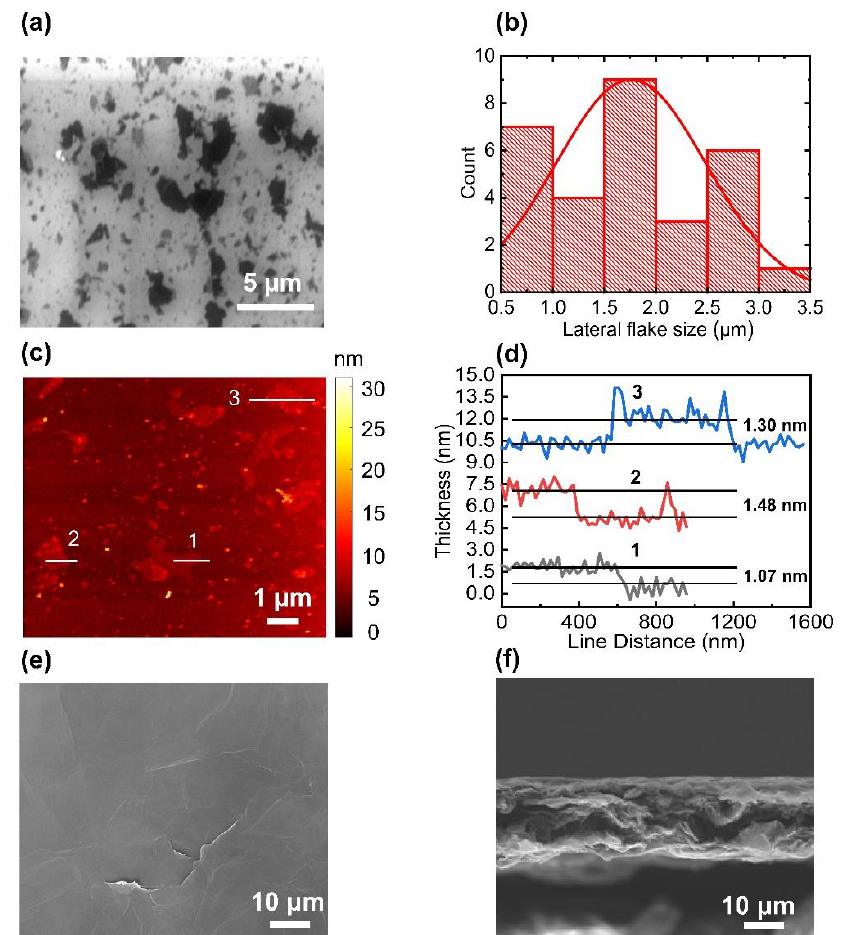
Figure 1. Morphologies of the EEG flakes and papers: ( a ) SEM image of the EEG flakes placed on an SiO 2 /Si substrate; ( b ) histogram of the lateral sizes of the EEG flakes, estimated from the SEM image (the red solid lines represent the Gaussian fits to the data); ( c ) AFM image of the EEG flakes placed on an SiO 2 /Si substrate; ( d ) representative AFM line profiles of the EEG flakes; ( e ) SEM image of the surface morphology of the EEG paper; ( f ) cross-sectional SEM image of the EEG paper.